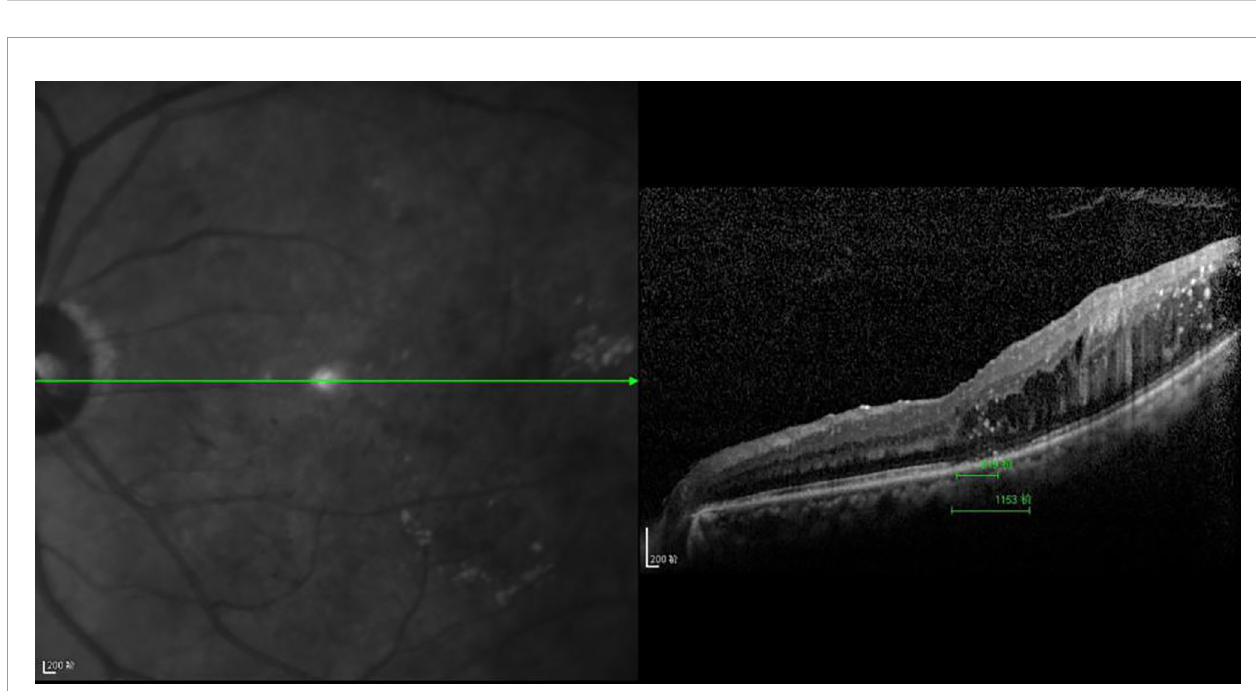
FIGURE 5 | OCT scanning of the ocular fundus in patients with DRME. The CFT value is 397 m m, the ELM layer is continuous, the fracture distance of the IS/OS layer is 139 m m, and there is outer retinal edema.